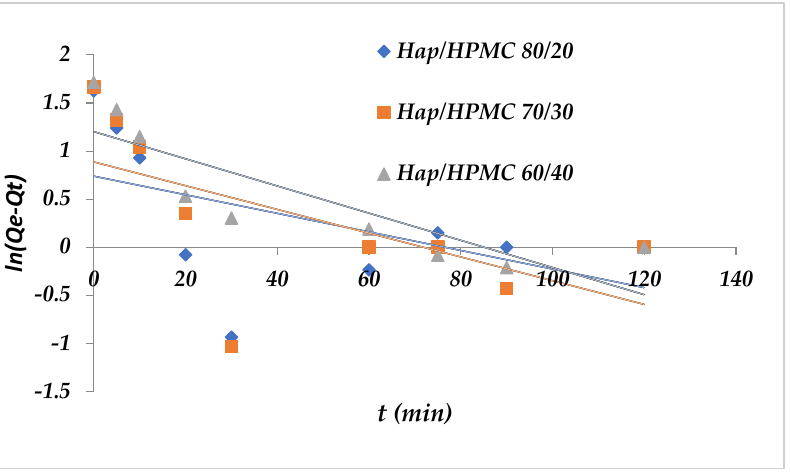
Figure 17. Pseudo-first-order kinetic model applied to the adsorption of MB by the composites.